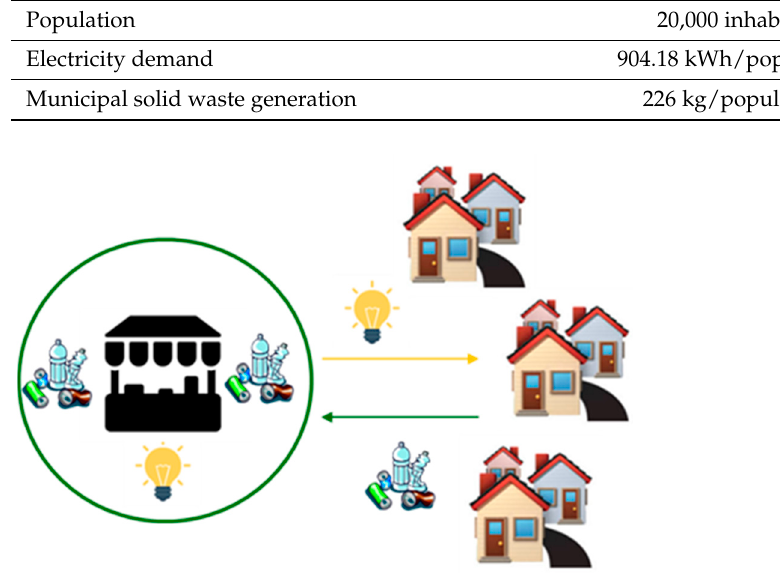
Table 2. Small–medium size neighborhood. Specification.